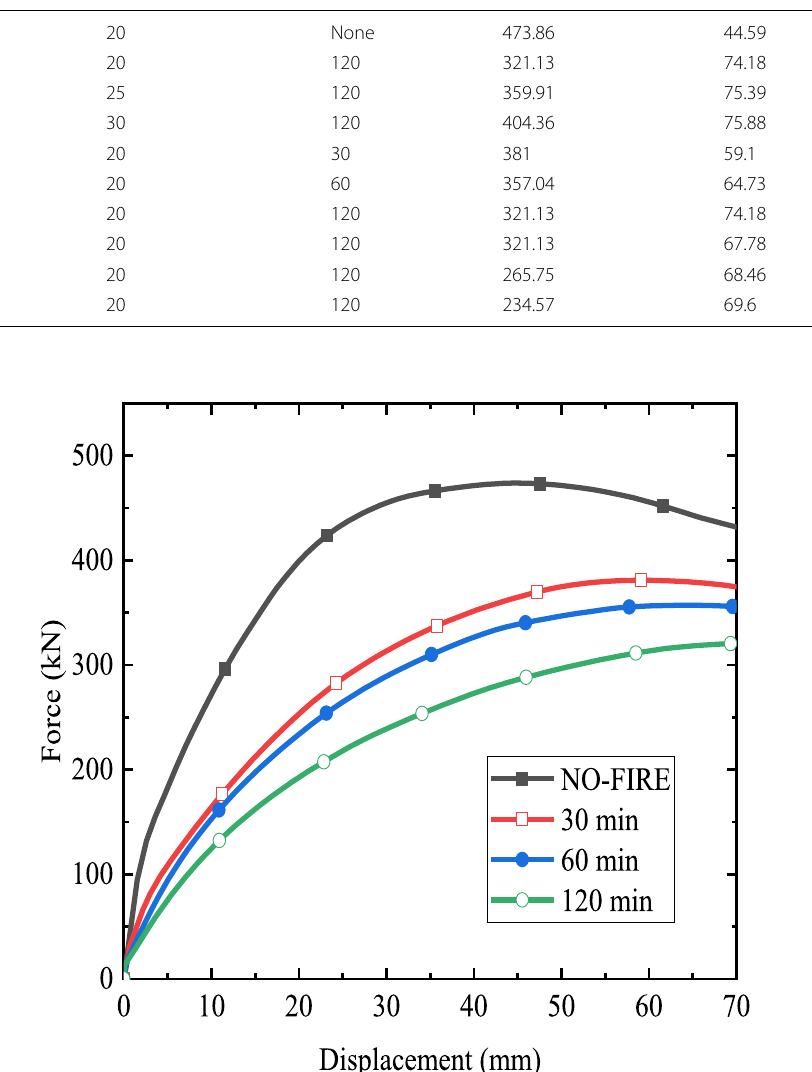
Fig. 42 Load-displacement curve for different durations of fire